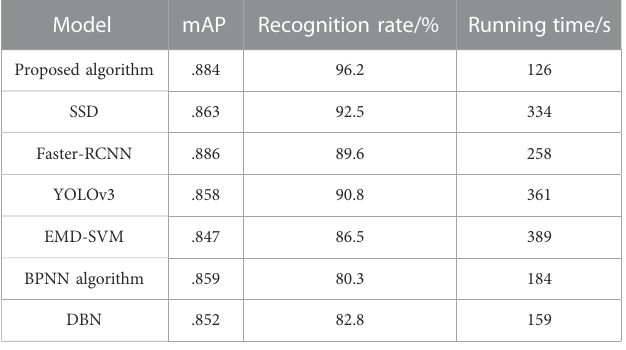
TABLE 7 Performance comparison under different